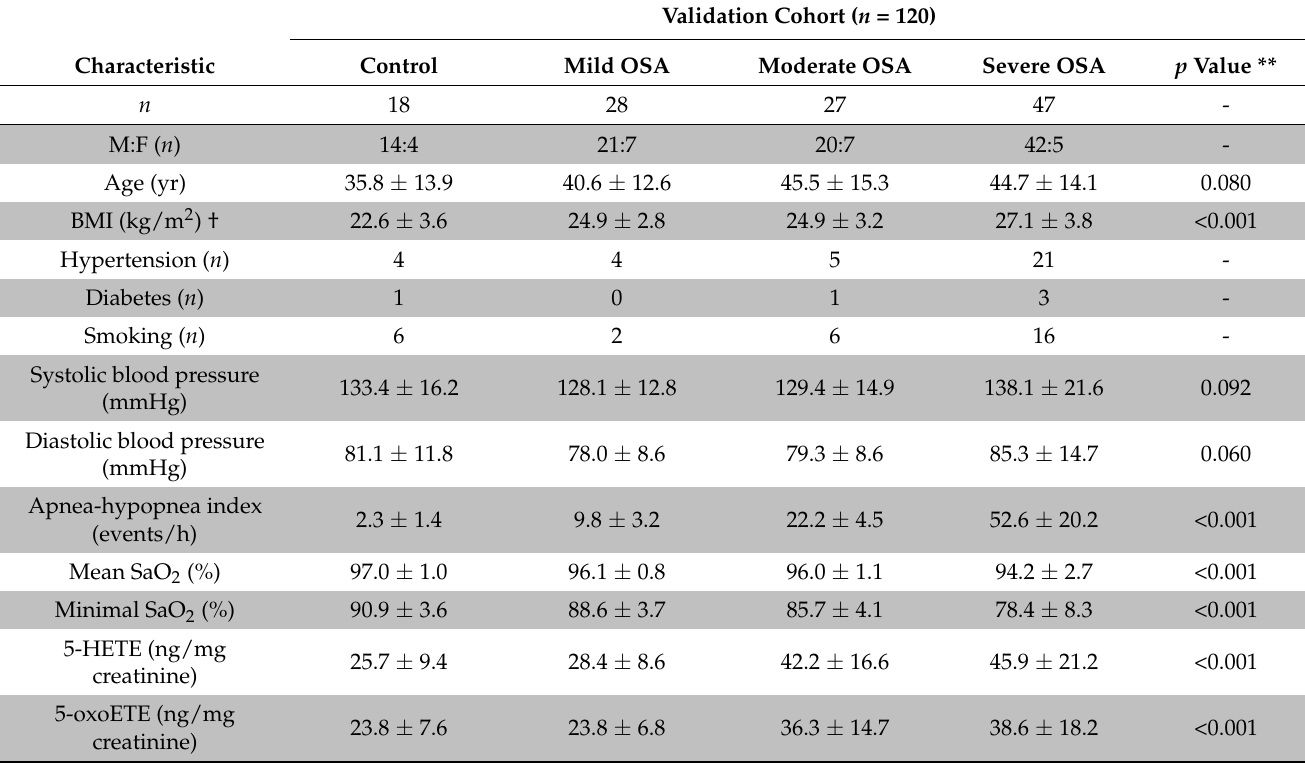
Table 2. Baseline characteristics of patients with the obstructive sleep apnea syndrome and controls